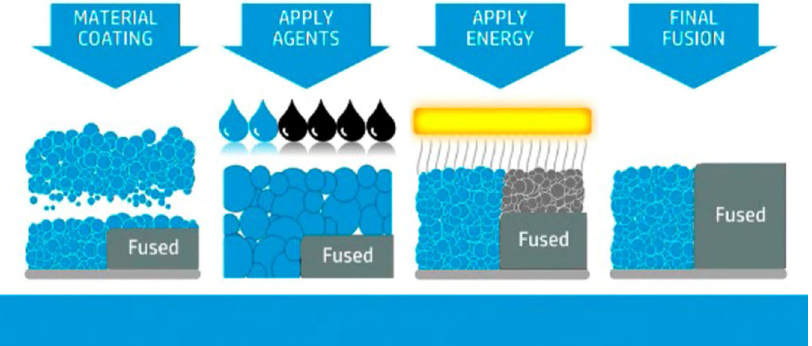
Fig. 1 | Diagram of additively manufacturing a part using the powder bed fusion-basedHPMultiJet Fusiontechnology. TheMJFprintprocessstartswitha CAD model that is sliced to form a stack of 2D images. The fi rst CAD model is printedusingablackIRabsorbingfusingagentontothepowderandthenheatedto meltusingthebroadareafusinglampsscannedvicinaltothebed.Adetailingagent